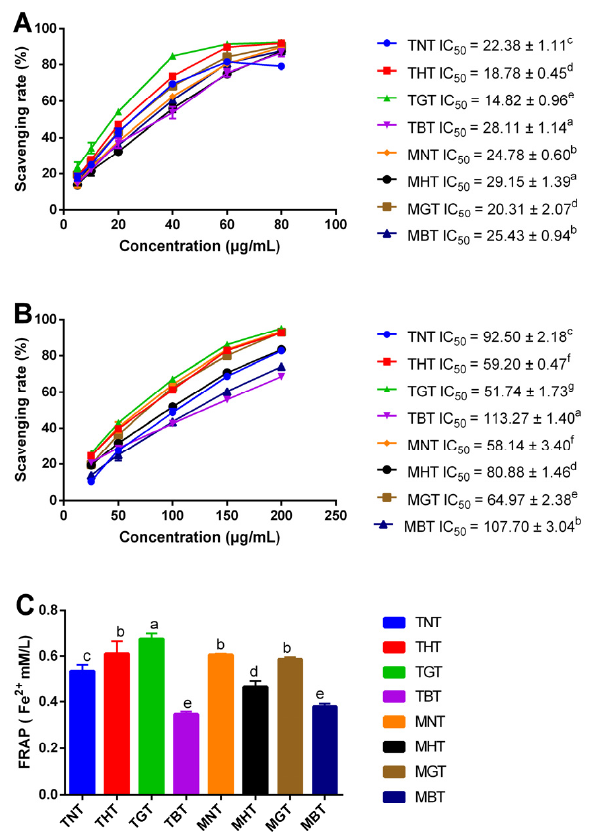
Figure 4. The antioxidant of lotus-leaf tea. ( A ) The capacities of DPPH radicals of eight lotus-tea extractions. ( B ) The capacities of ABTS + radicals of eight lotus-tea extractions. ( C ) FRAP abilities of eight lotus tea extractions. Different letters (a–g) indicate significant differences ( p <